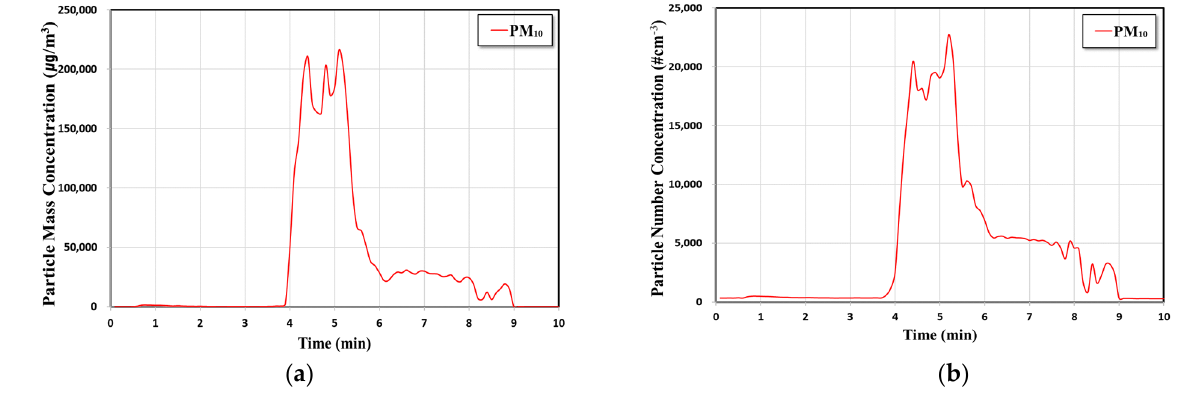
Figure 7. Scattered dust during cutting (test ID 1). ( a ) PMC and ( b ) PNC.